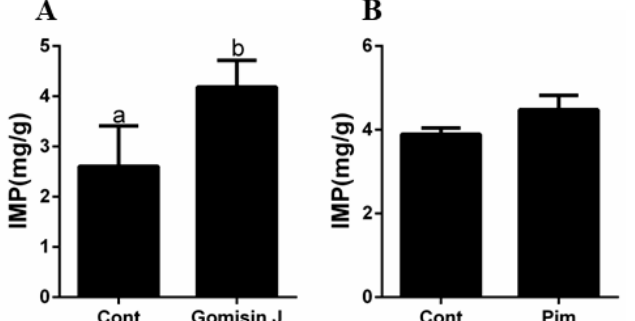
Figure 7. The effects of Gomisin J and Pim on triploid crucian carp flavoring substance inosine monophosphate (IMP) at different time points. ( A ) The effects of Gomisin J on IMP content at 72 h. ( B ) The effects of Pim on IMP content at 72 h. Data are presented as means ± SE ( n = 3). Different letters indicate significant differences ( p < 0.05).